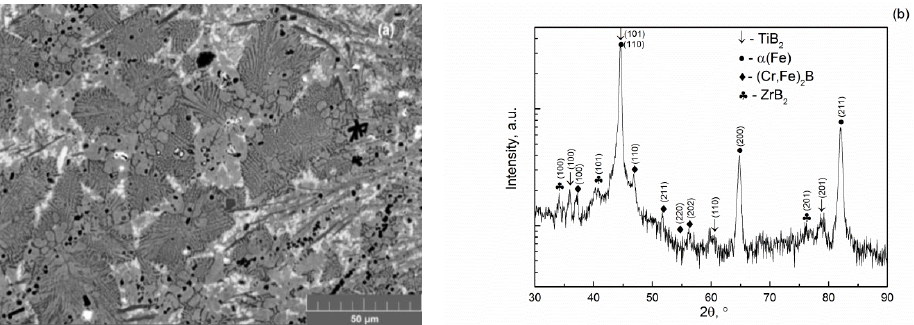
Figure 1. As-cast microstructure (SEM) of the investigated steel ( a ) and XRD pattern ( b ). Table 1. The size of the borides in the as-cast state and after hot deformation (HD). Average Size of the Particles, µ State